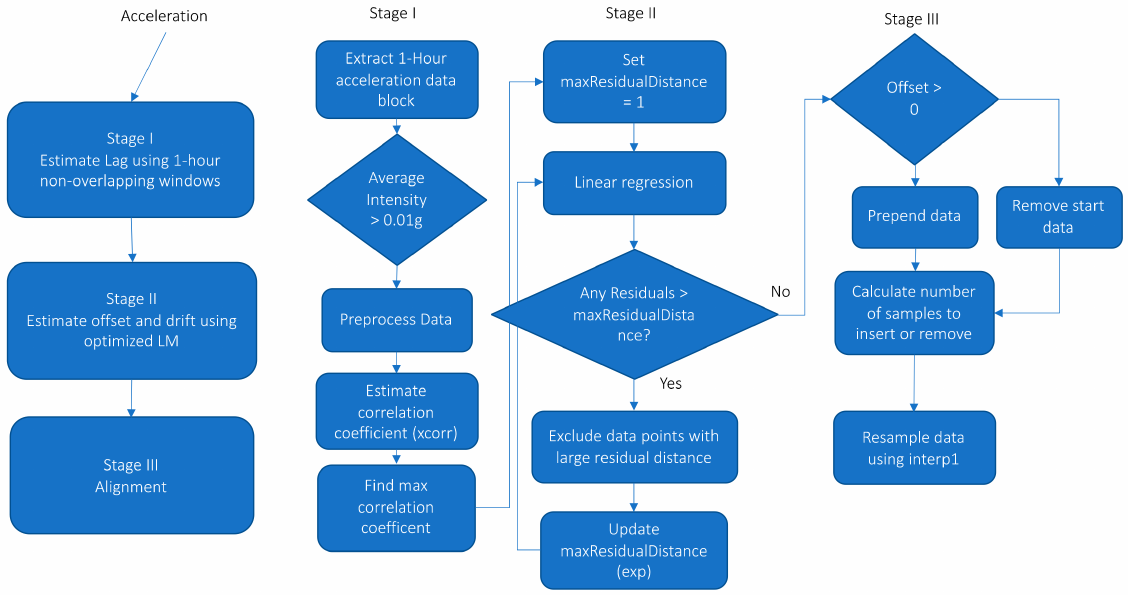
Figure 1. Overview of the three stages and individual processing steps used in the temporal alignment